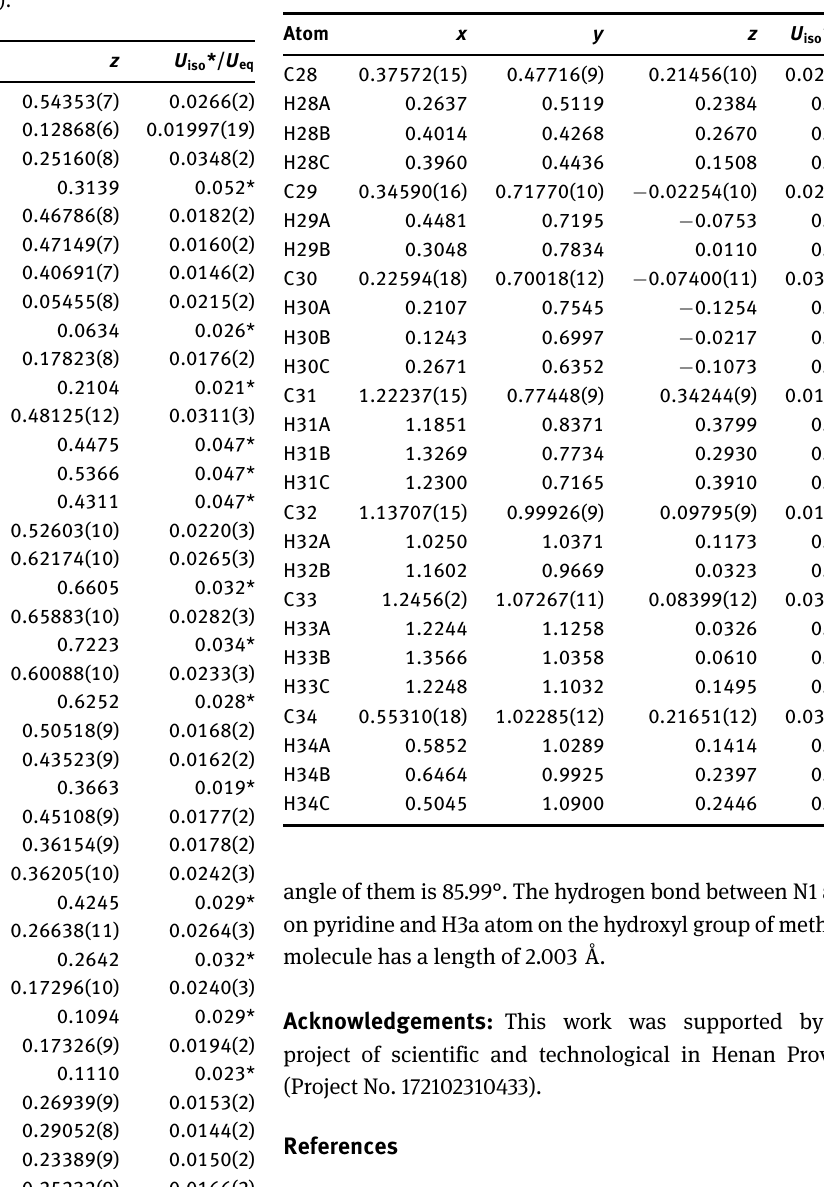
Table 2: Fractional atomic coordinates and isotropic or equivalent isotropic displacement parameters (Å 2